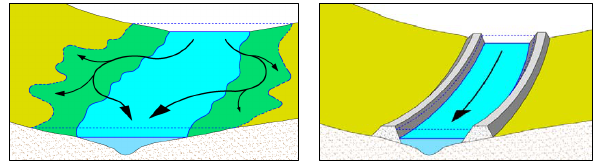
Figure 1. Humans alterations of physical processes in floodplains: Schematic example of 3 Fig. 1. Humans’ alterations of physical processes in floodplains: unprotected floodplains, which typically exhibits richness of natural processes and complex 4 schematic example of unprotected floodplains, which typically ex- inundation patterns [left panel]; Schematic example of protected floodplain, whereby flood 5 hibits richness of natural processes and complex inundation patterns propagation processes are typically controlled by man-made structures, such as levees or 6 (left panel); schematic example of protected floodplain, whereby flood propagation processes are typically controlled by man-made dikes [right panel]. 7 structures, such as levees or dikes (right panel).